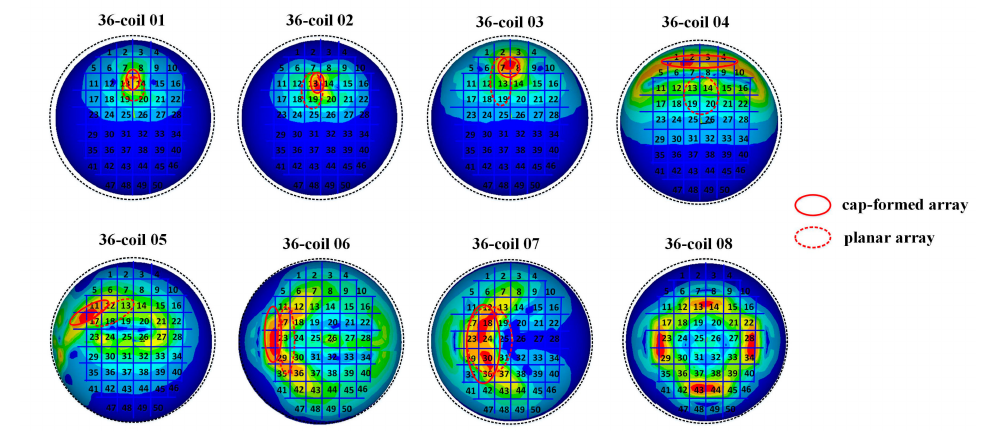
Figure 13. The comparison of the planar array and the cap-formed array. Red full lines indicate cortical regions activated by the selected coils in the cap-formed array. The dashed lines show cortical tissues stimulated by the same corresponding coils in the planar